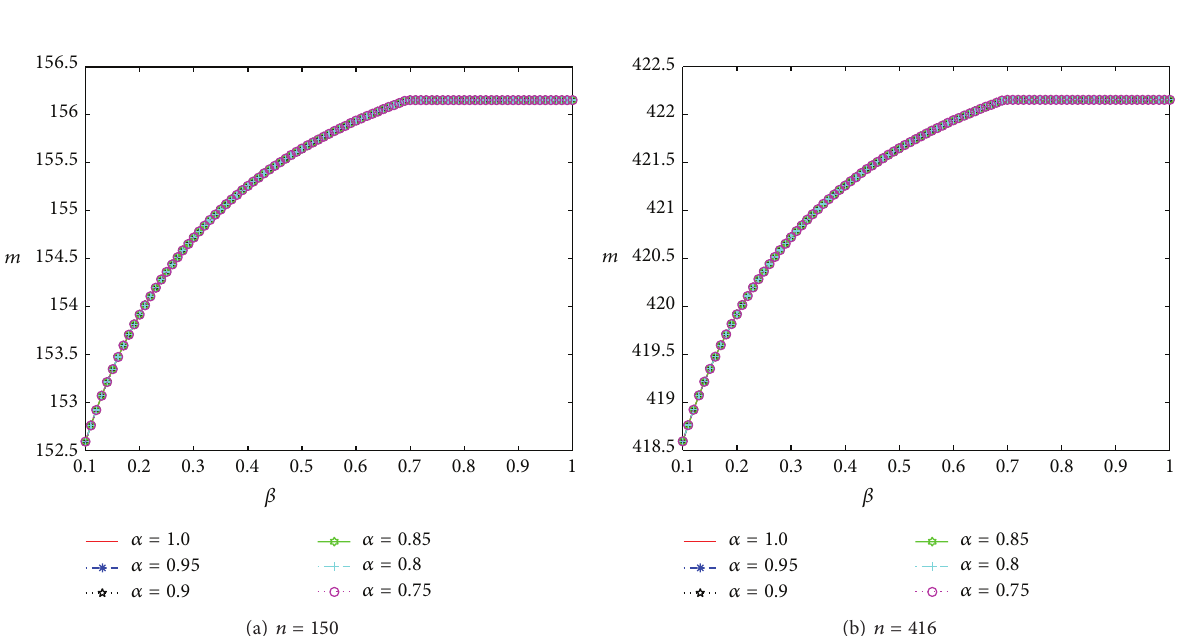
Figure 1: Optimal booking limit 𝑚 ∗ under the changes of 𝛼 and 𝛽 when 𝑏 = 8,𝑗 = 5 .